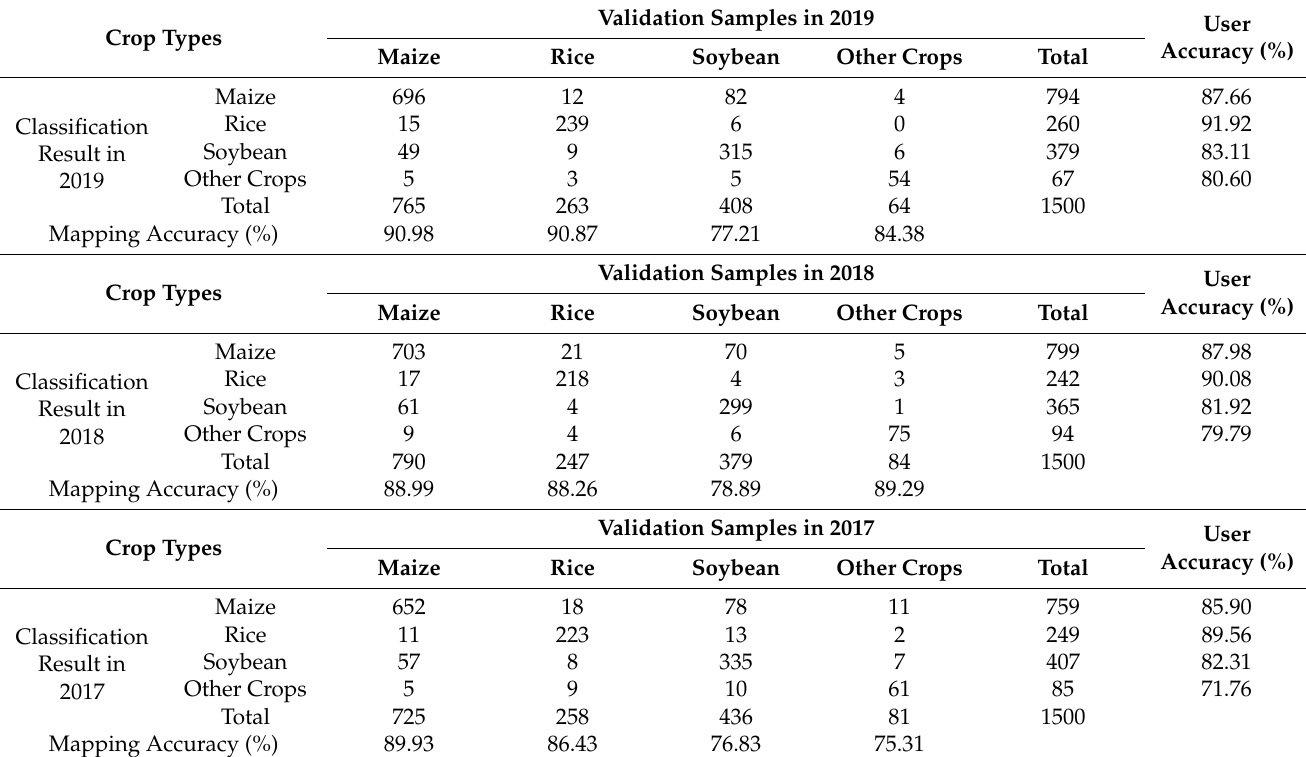
Table 2. Confusion matrix between crop type classification result and validation